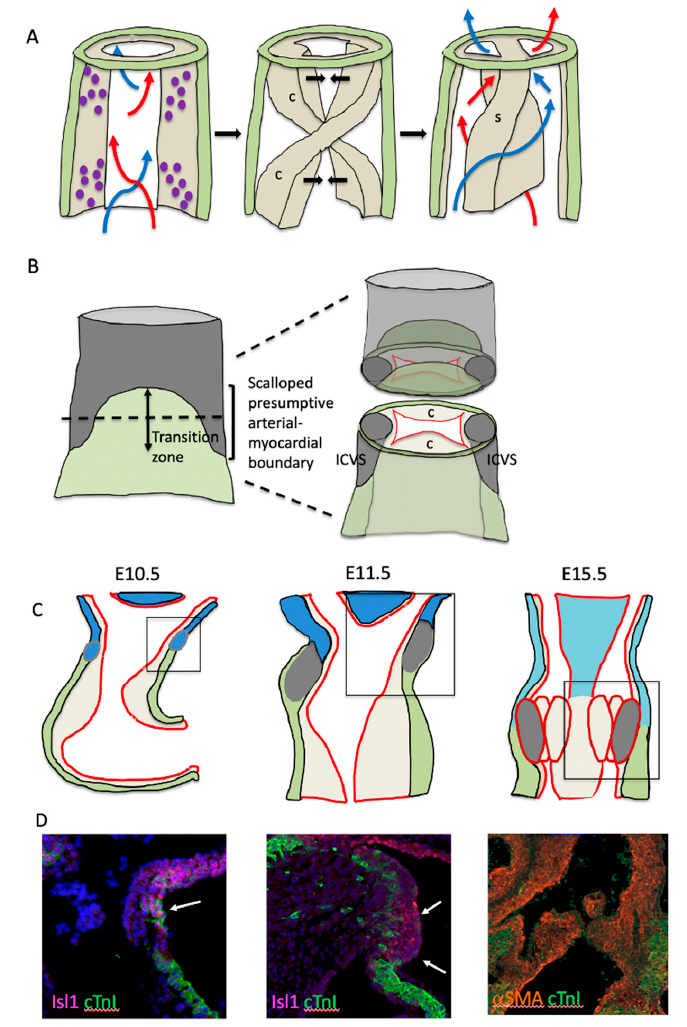
Figure 2. Early outflow tract development. ( A ) Model representing how flow of blood through the unseptated outflow tract may lead to formation of the spiralling outflow septum. Vorticial flow of blood through the outflow tract as the cushions are beginning to cellularise leads to aggregation of these cells (purple dots) in columns that prefigure the spiralling cushions (c). This positions and/or stabilises the cellularising cushions within the circumference of the outflow tract. The ensuing fusion of these cushions leads to formation of a spiralling septum (s) that places the root of the aorta to the left of the pulmonary trunk. ( B ) The boundary between myocardial and non-myocardial fate is first apparent at 10.5 in the mouse as the transition zone. The cells in this region are transitioning from a progenitor (grey) to a cardiomyocyte (green) fate. However, not all the undifferentiated SHF cells within this boundary region become cardiomyocytes. Two tongues of undifferentiated SHF cells can be seen to extend laterally into the myocardial outflow tract and these form the intercalated valve swellings (ICVS) that are the primordia of the posterior (non-coronary) and anterior intercalated leaflets of the aortic and pulmonary valves. ( C , D ) The myocardial-non-myocardial boundary is labelled by Isl1 (pink) and cTnI (green) at E10.5, with the cells in the transition zone labelled by both markers (arrow). By E11.5 the ICVS can clearly be seen in the outflow wall, as it continues to express Isl1 (arrows). By E15.5 the myocardial (green)-SMC (red) boundary at the level of the valve complex is well defined.